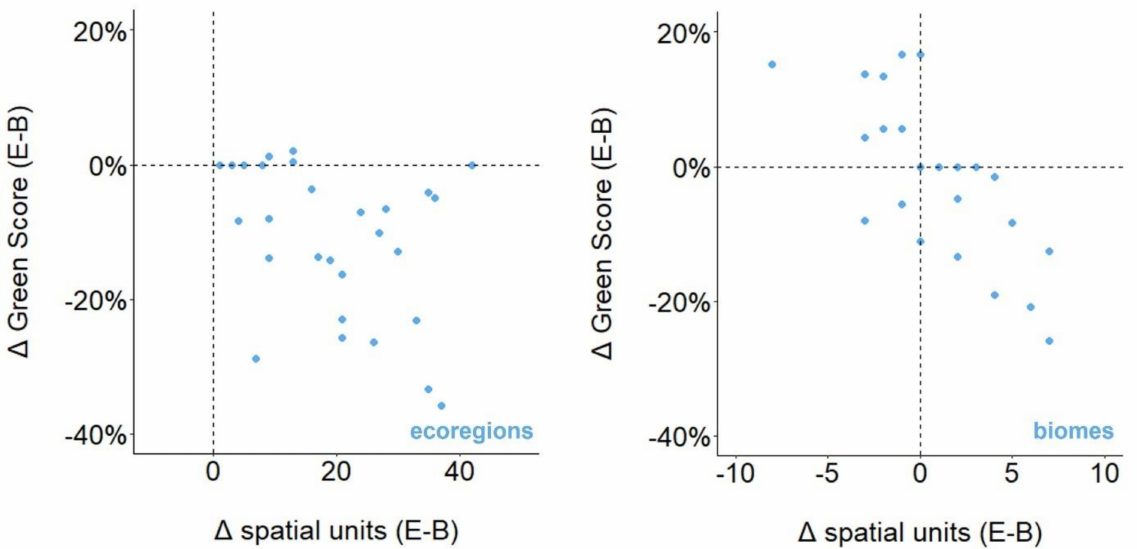
Figure 4. Change in Green Score as a function of change in number of spatial units when comparing ecologically based spatial units (SUs) with biologically based SUs (ecologically based results minus biologically based results; E-B). Each point represents a species ( n = 29). Dashed lines intersect at the origin. Note the different x-axes. ( Left ): Comparison of results between fine-scale ecologically based spatial units (ecoregions) and biologically based spatial units. ( Right ): Coarse-scale ecologically based spatial units (biomes) compared to biologically based spatial units. Negative values on either axis indicate lower values were generated using ecologically based SUs compared to biologically based